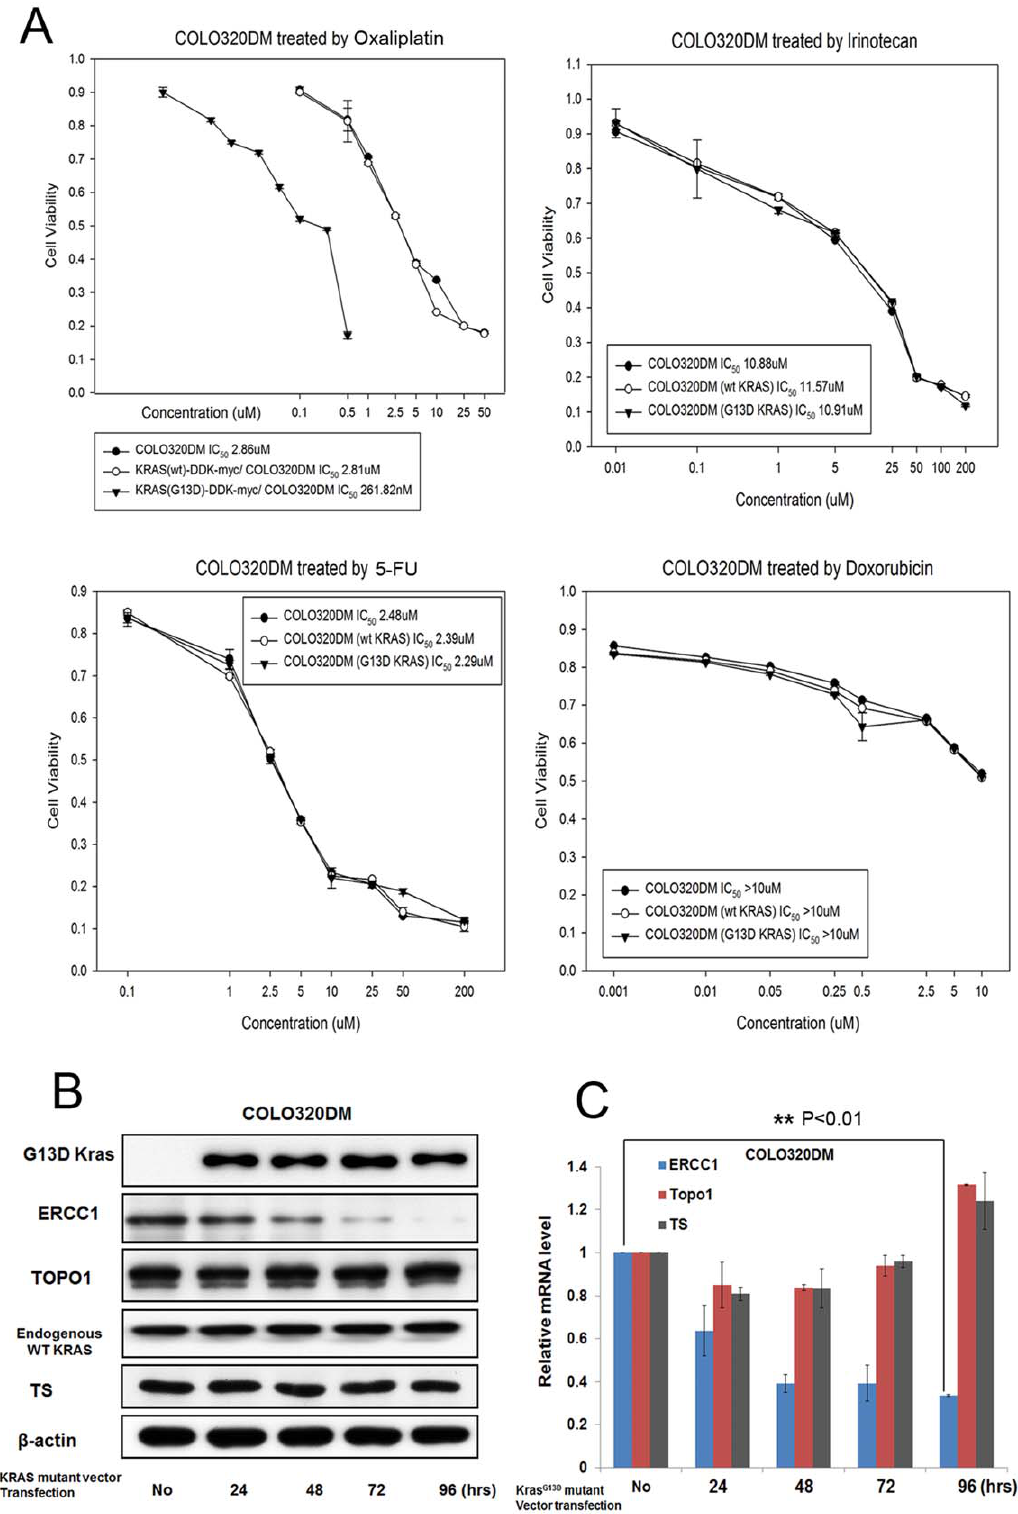
Figure 3. Overexpressing KRAS in KRAS wild-type CRC cells leads to oxaliplatin sensitivity and ERCC1 downregulation. (A) KRAS G13D - DDK-myc-COLO320DM cells were more sensitive to oxaliplatin, but have the same sensitivity to irinotecan, 5FU, and doxorubicin than parental COLO320DM cells, as demonstrated by MTT assay. (B) The protein level of ERCC1, but not those of TOPO1 or TS, was downregulated after COLO320DM cells were transfected by the KRAS G13D mutant vector. (C) The mRNA level of ERCC1, but not those of TOPO1 or TS, was downregulated after COLO320DM cells were transfected by the KRAS G13D mutant vector. **: p , 0.01.